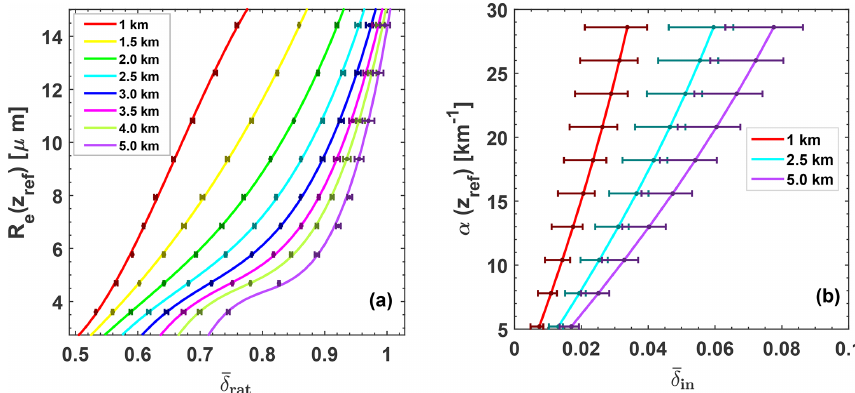
Figure 7. (a) Droplet effective radius R e (z ref ) as a function of δ rat = δ in /δ out for (cid:49)z ref = 75m and (b) relationship between the measured δ in for FOV = 1mrad and cloud extinction coefficient α . Eight different cloud layers with base height z bot from 1 to 5km height (given as numbers in the panels) are simulated in (a) , and three different layers are simulated in (b) . For each cloud layer (indicated by different colors) simulations with all combinations of R e – α profile pairs (in Table 1) are performed. The small bars in (a) indicate the range of possible δ rat values for the whole range of α values at a given R e value, which indicate the very low influence of α on the R e retrieval (simulated α range is given in Table 1). A polynomial regression is applied to the mean values of δ rat . This regression analysis is performed for each of the eight cloud layers. The cubic model (Eq. 26) for each cloud layer is indicated as thick solid colored line. The bars in (b) indicate the range of possible δ in values for a given α value. Here, the length of the bars indicate the relatively strong R e influence on the α(z ref ) retrieval (simulated R e range is given in Table 1). The respective regression analysis leads here to the thick solid lines calculated with Eq.